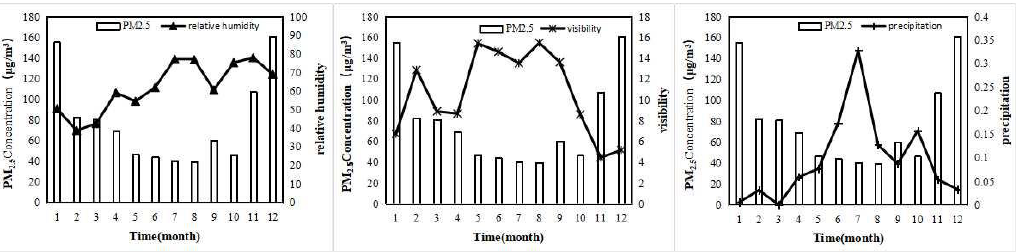
Figure 4 The relationship between PM 2.5 Concentration and Meteorological Elements